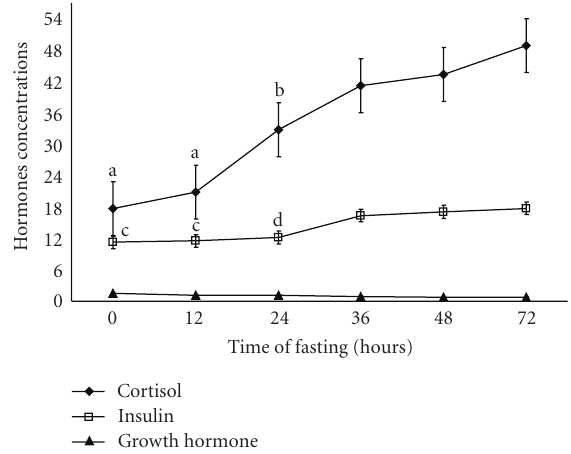
Figure 2: Concentration of Cortisol ( μ g/dl), Insulin hormone ( μ Iu/ml) and Growth hormone in experimentally pregnancy tox- emic goats. Di ff erences in the letters indicate beginning of the significant di ff